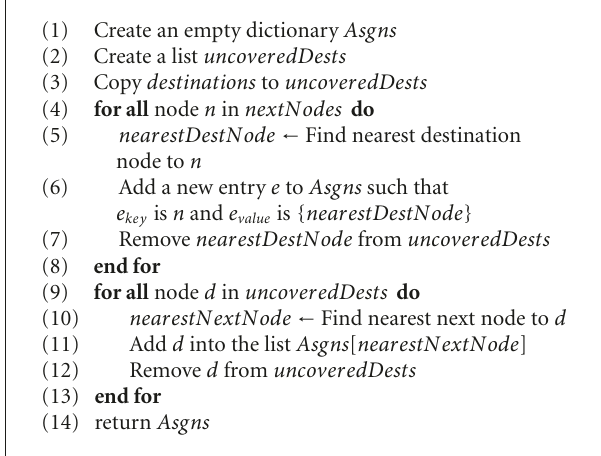
Algorithm 3: Assignment of Destination Nodes to Next Nodes in